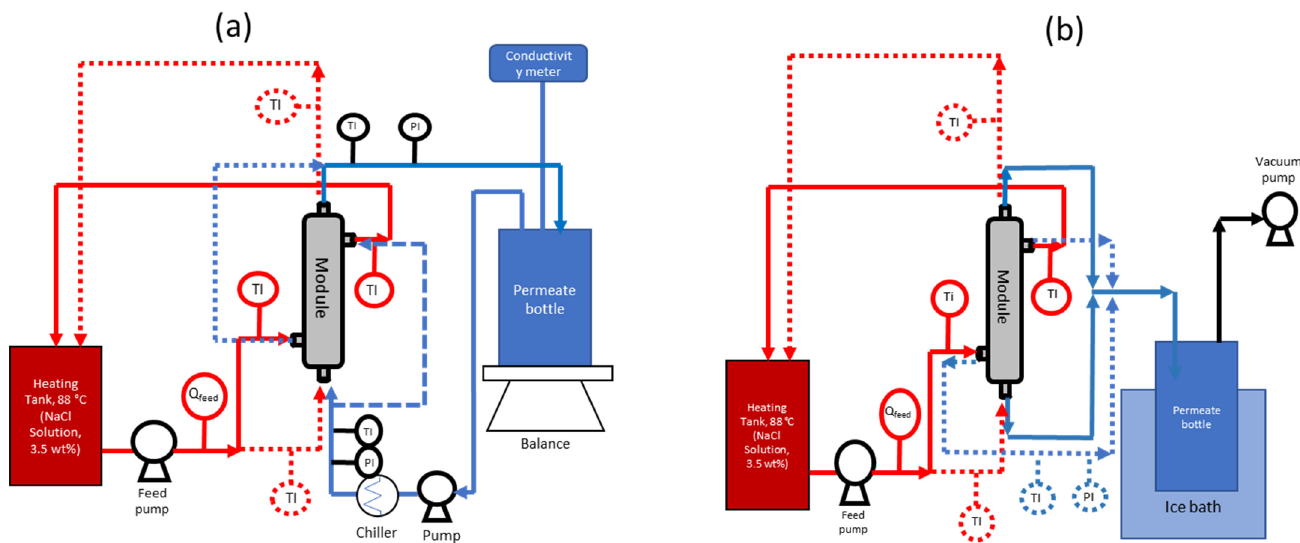
Figure 2. Schematic of the membrane distillation test skids operated in ( a ) direct contact membrane distillation (DCMD) mode and ( b ) vacuum membrane distillation (VMD) mode. The red lines indicate the flow path of the hot feed (salty water), and the blue lines indicate the flow path of the cold permeate. The solid lines in both figures indicate operation under the “out-to-in” configuration, and the dotted lines indicate operation in “in-to-out” configuration.